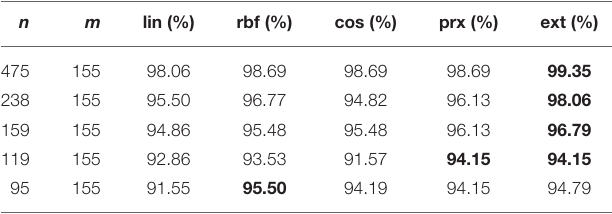
FIGURE 3 | (A) A strong linear relation is seen between the VC-bound for cosine kernel µ ∗ cos VC and class size m r . The dashed line marks y linear kernel, however, was a constant µ ∗ lin VC 439. (B–E) The scatter plots of accuracy scores for cosine (cos), linear (lin), exact (ext), and Gaussian RBF (rbf) kernels = m vs. the effective sample size 2 m r /µ ∗ VC ; the accuracy scores of exact and cosine kernels increased with the effective sample size, whereas those of Gaussian RBF ˜ = and linear kernels tended to decrease with the effective sample size. (F) The ratio of ext vs. rbf accuracy scores is positively correlated with the ratio effective sample